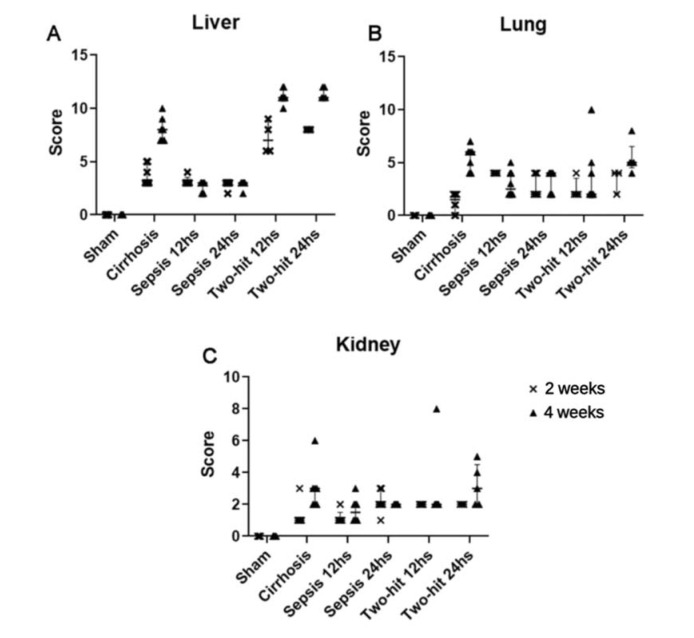
Median score values of histopathological findings (*p<0.05, **p<0.01, ***p<0.001, ****p<0.0001 for comparisons against the sham group).